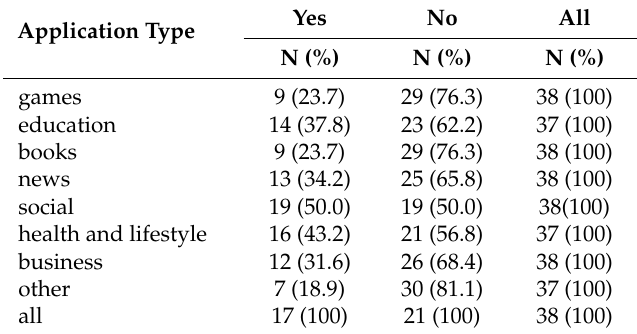
Table 6. What type of applications do you download?